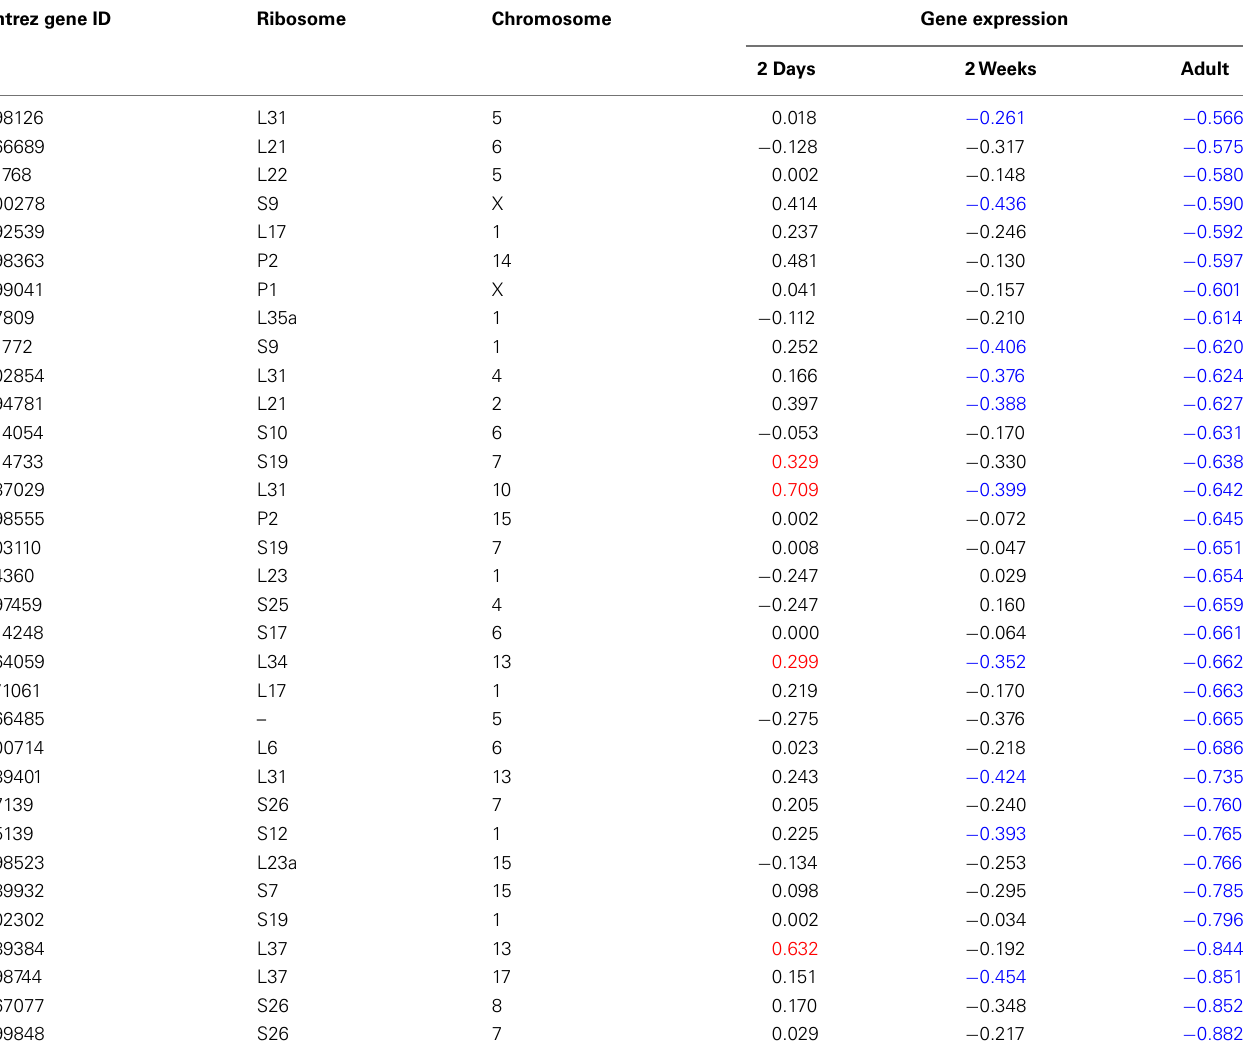
adult males, i.e., 36weeks]. The difference in gene expression between molsidomine-treated and control FHH was noted as Log 2 (FM/FC), where FM and FC are the normalized intensities. Red and blue numbers indicate gene expression differentially induced and reduced by molsidomine, respectively.The symbols and the chromosomal locations are also shown. Ratios indicated in bold and red are increased differential expression and ratios indicated in bold and blue are decreased differential expression. Note that some genes in (A) may reappear in (B,C) and some genes inTable A2B may reappear inTable